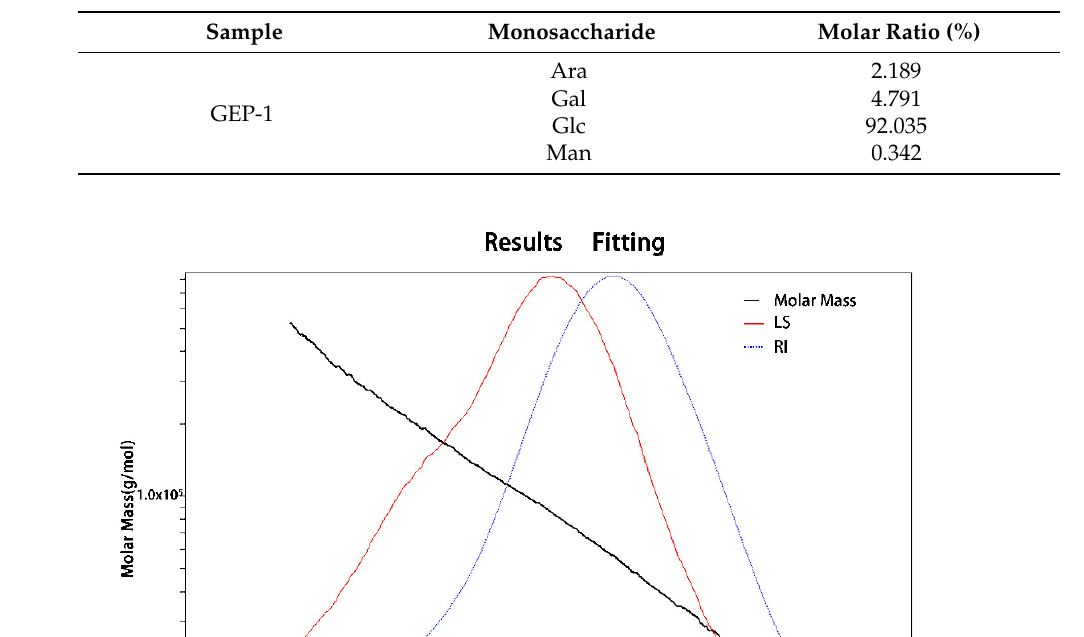
Table 1. Monosaccharide composition of GEP-1. The undetected monosaccharides are not listed in the table.